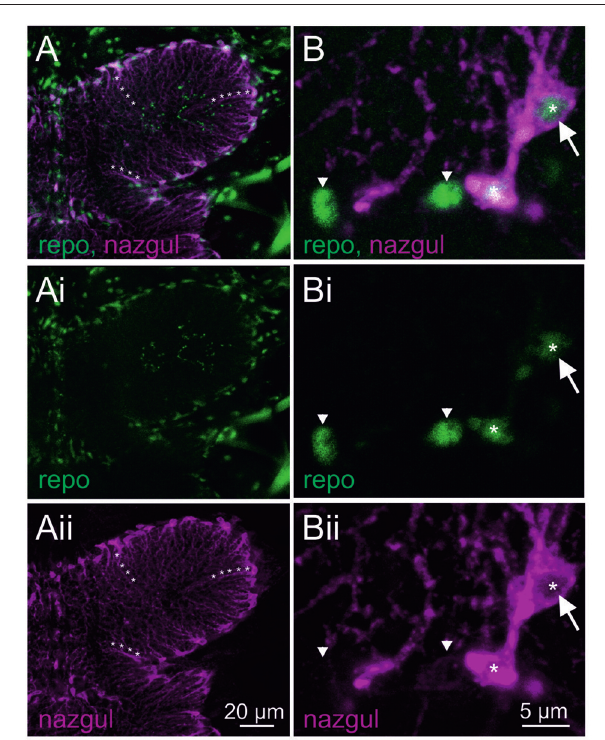
FIGURE 3 | Naz-RNAi effectively knocks down Naz protein. Western blotting with control fly homogenate reveals a prominent band at the predicted size of the Naz protein (45.5 kD) that is not detectable in homogenate from flies with expression of UAS- naz -RNAi under the control of Repo-GAL4. Heat shock protein 90 (hsp90) serves as loading control and is detected at similar levels in control and naz- RNAi knock down